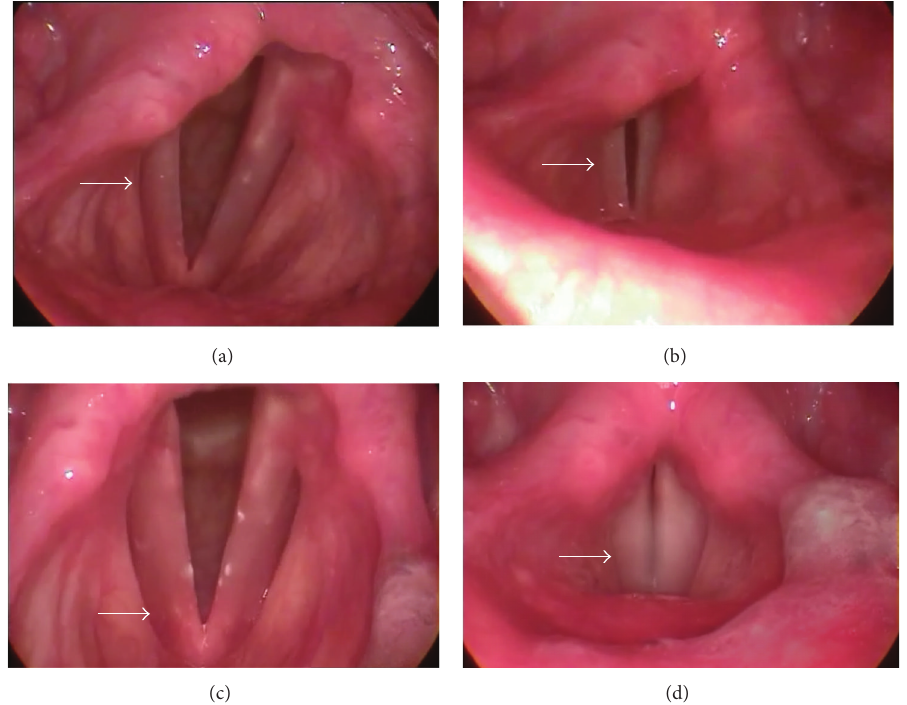
Figure 1: Video laryngoscopy showing immobility of the right vocal fold in a paramedian position, either in abduction (a) or in adduction (b) of the glottis. After 8 months, showing normal mobility of both vocal fold, either in abduction (c) or adduction (d) of the